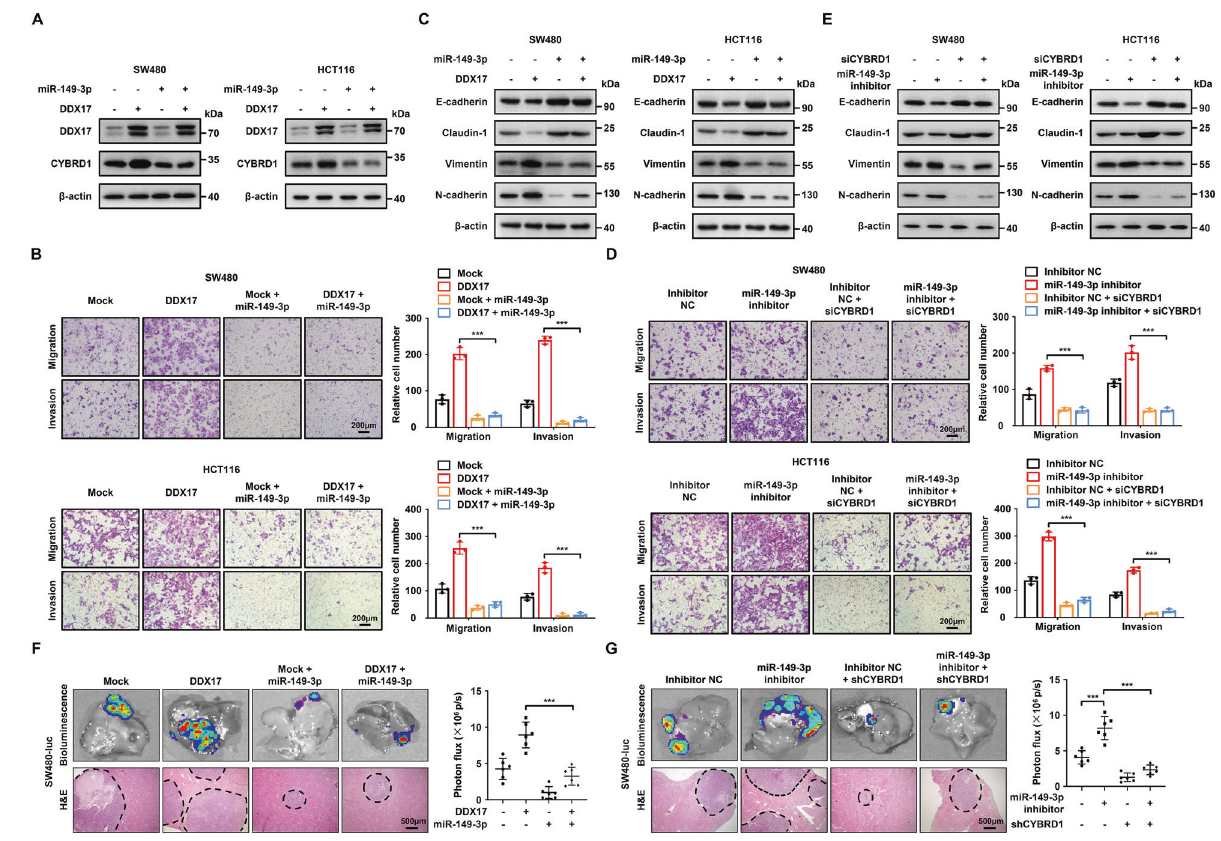
Fig. 6 The miR-149-3p/CYBRD1 pathway is required for DDX17-induced CRC cell migration and invasion. A Western blot analysis of CYBRD1 expression in SW480 and HCT116 cells infected with DDX17 and/or miR-149-3p lentivirus. B Transwell assays in SW480 and HCT116 cells infected with DDX17 and/or miR-149-3p lentivirus. C Western blot analysis of EMT marker expression in SW480 and HCT116 cells infected with DDX17 and/or miR-149-3p lentivirus. D SW480 and HCT116 cells infected with miR-149-3p inhibitor lentivirus were transfected with or without speci fi c siRNA targeting CYBRD1, and then subjected to transwell assays. E SW480 and HCT116 cells infected with miR-149-3p inhibitor lentivirus were transfected with or without speci fi c siRNA targeting CYBRD1, and then subjected to western blot analysis of EMT marker expression. F SW480 cells infecting DDX17 lentivirus together with or without miR-149-3p lentivirus were injected into the spleens of nude mice. Representative bioluminescent and H&E staining images of the isolated liver tissues were obtained, and the light emissions were quanti fi ed. G SW480 cells infecting miR-149-3p inhibitor lentivirus together with or without CYBRD1 shRNA lentivirus were injected into the spleens of nude mice. Representative bioluminescent and H&E staining images of the isolated liver tissues were obtained, and the light emissions were quanti fi ed. *** P < DDX17 was positively associated with CYBRD1 protein expression in CRC samples ( R 2 = 0.4036, P < 0.001, Fig. 5J). These data indicate that